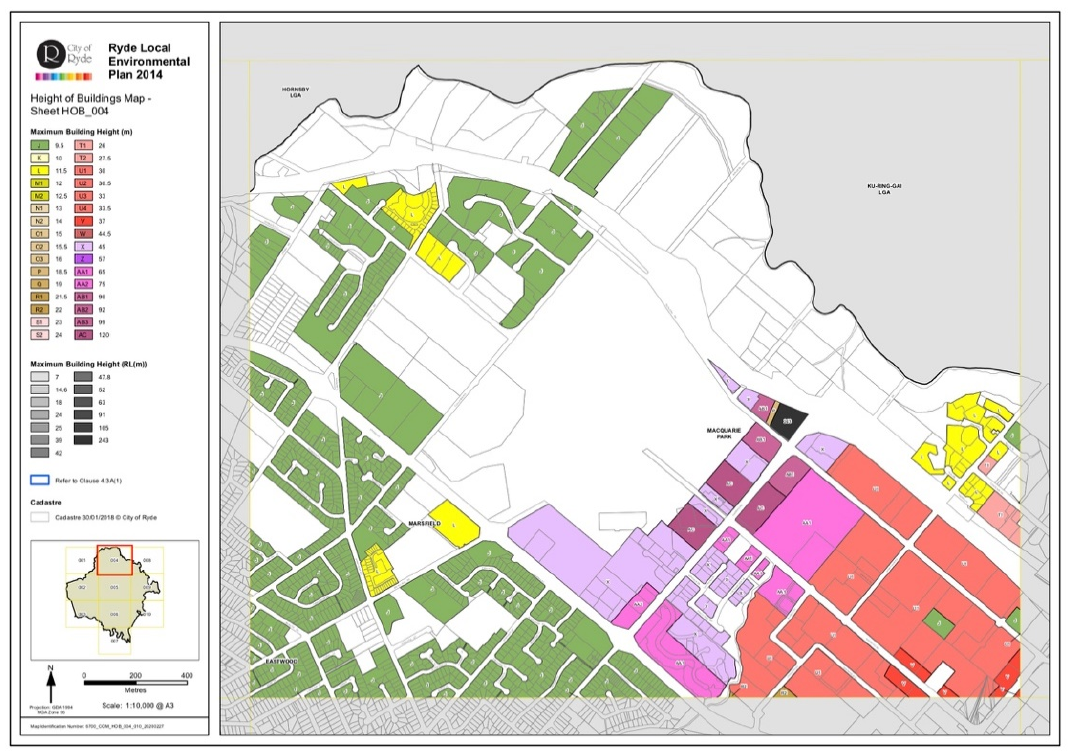
Figure A6. Macquarie Park Land Zoning Map LEP.